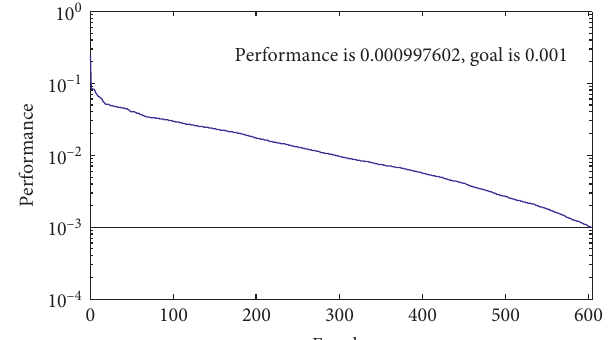
Figure 15: Error performance curve of RBF neural network test result.